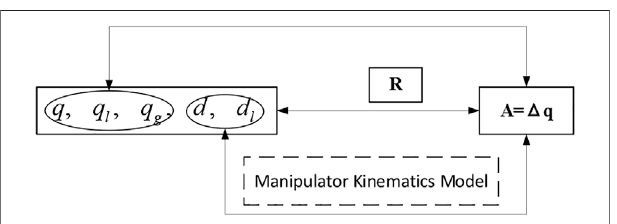
FIGURE 4 | State space and action